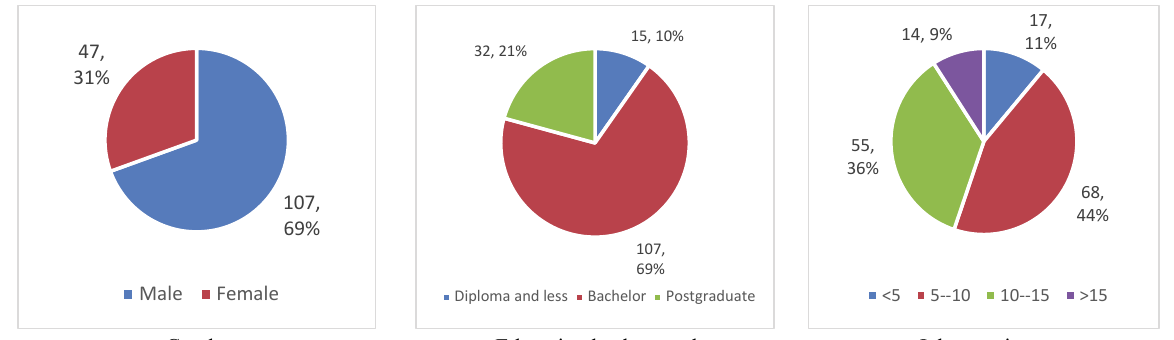
Fig. 2. Personal characteristics of the